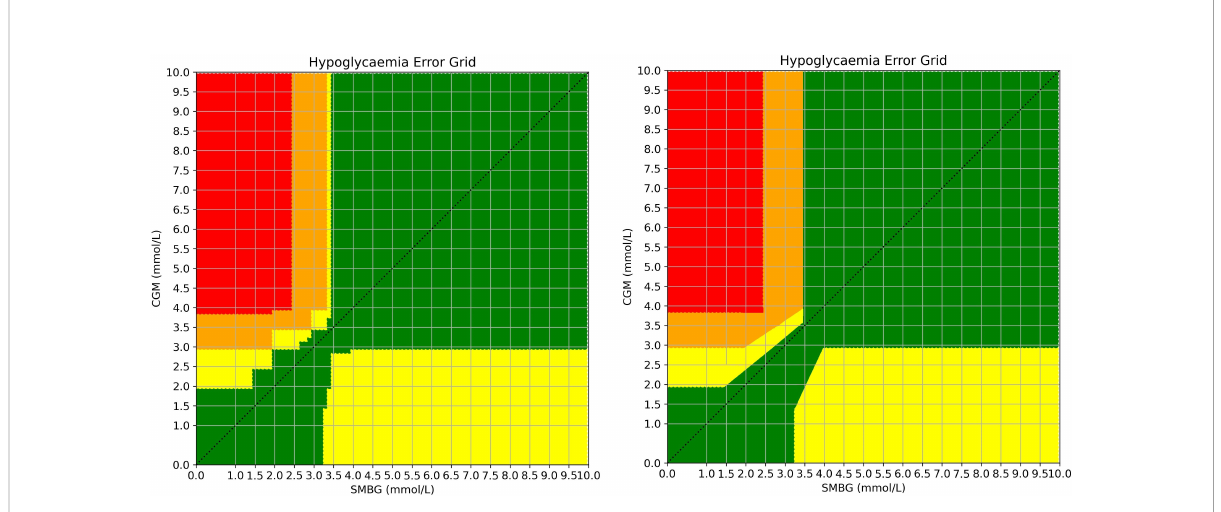
FIGURE 2 Demonstration of the averaged risk scores for all 10,000 combinations of SMBG vs CGM values before (left) and after smoothing (right). Risk levels: green = A, yellow = B, orange = C, red = D. The original grid generated by responses is demonstrated on the left with the smoothed grid on the right. For the fi nal version, the slim vertical yellow column and the adjacent orange sections were combined. Staggered edges were converted to angled straight lines by consensus to aid usability and